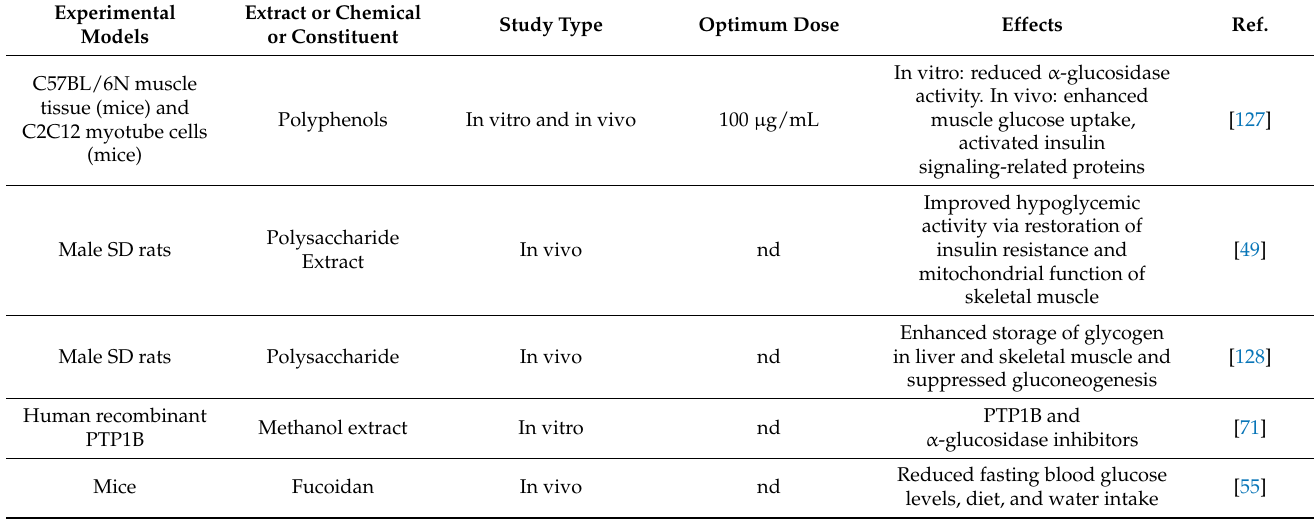
Table 11. Summary of antidiabetic activity of H. fusiformis